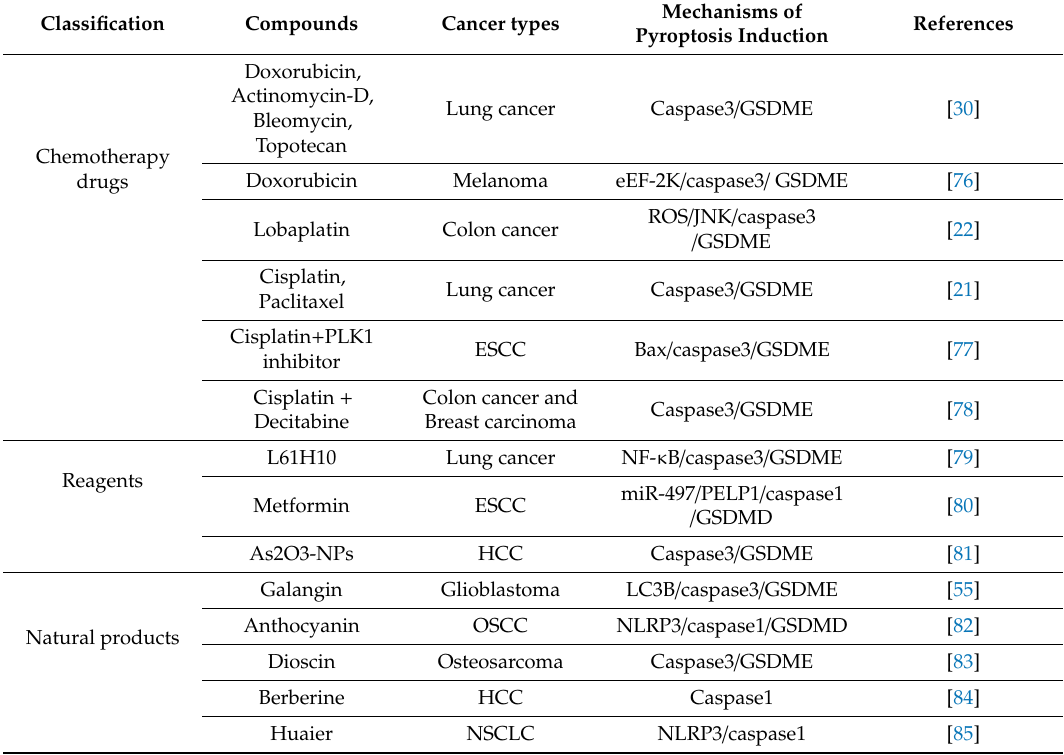
Table 2. Compounds inducing pyroptosis signal pathways in related